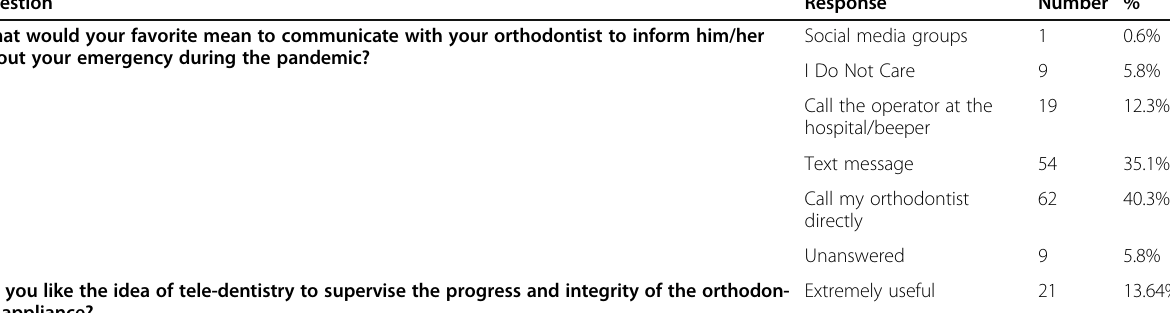
Table 4 Section 4: Patient/orthodontist follow-up during the pandemic Question